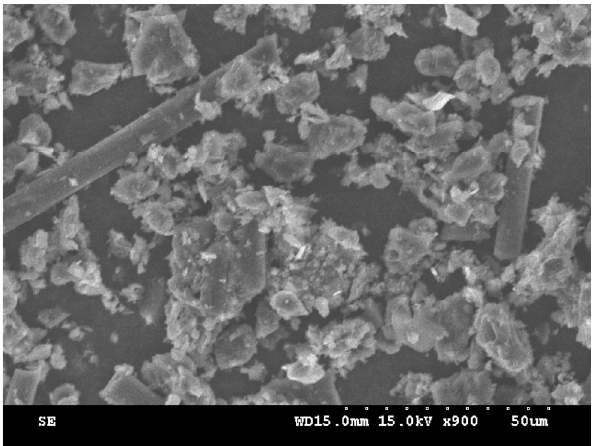
Fig. 14 SEM image of the worn debris of CpC5 showing chunks of eroded matrix.